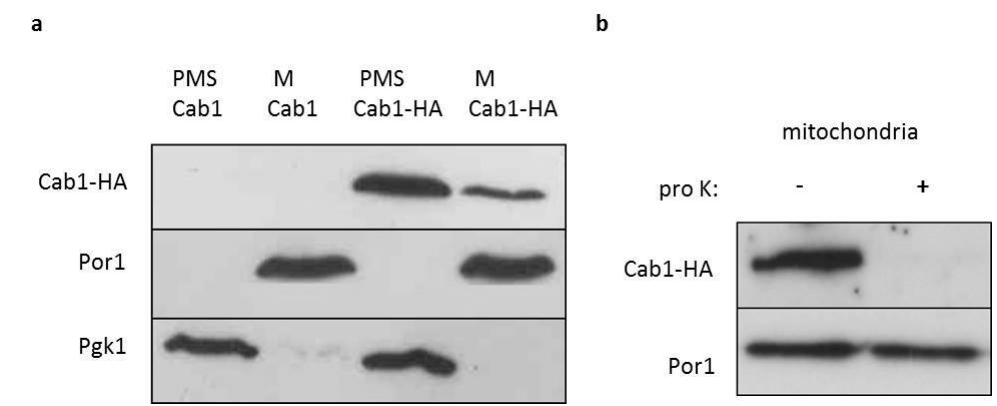
Figure 1. Localization of Cab1p. ( a ) Equal amounts (20 mg) of the mitochondrial fraction (M) and post-mitochondrial supernatant (PMS) extracted from Δ cab1 strain harboring pFL39 CAB1 or pFL39 CAB1 HA were resolved by SDS-PAGE and analyzed by immunoblotting with HA, Pgk1 (cytosolic marker) and Por1 (mitochondrial outer membrane marker) antibodies. The experiment was performed on two independent clones for each strain ( N = 1; n = 2) ( b ) Mitochondria were treated at 4 °C for 60 min with proteinase K (pro K) (1 mg/mL). The filter was incubated with anti-HA and anti-Por1 antibodies. The experiment was performed on two independent clones of Δ cab1 strain harboring pFL39 CAB1 HA ( N = 1; n = 2).